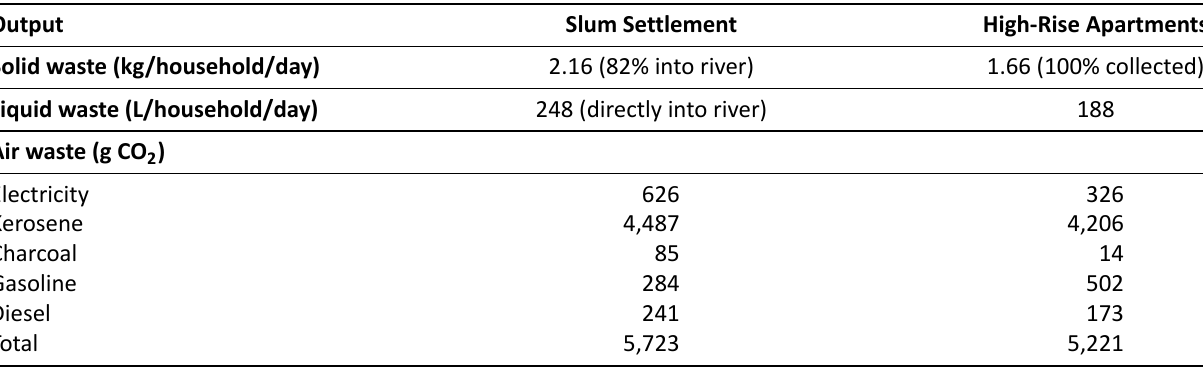
Table 2. Waste outputs from Ciliwung River slum settlement and high-rise apartments, Jakarta, Indonesia. Source: Arief (1998).